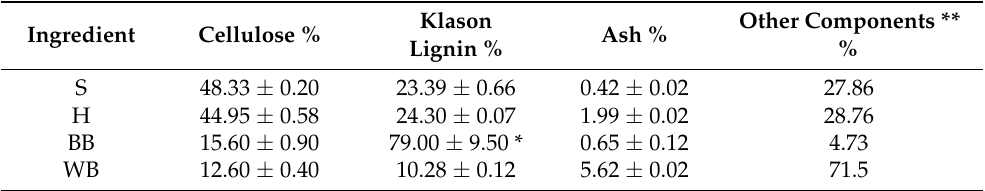
Table 3. Chemical composition of mycelium biocomposites’ ingredients. S = birch